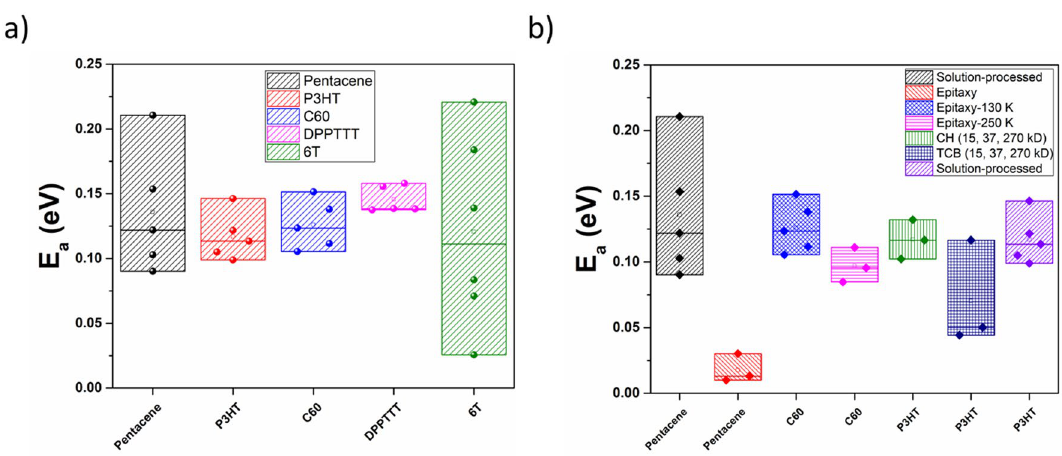
Figure 4. ( a , b ) Plots consisting of activation energy (E a ) derived from the Renormalization Model, accessed by different OFETs. The horizontal axes denote the semiconductor for which the activation energy E a is plotted on the vertical axes. For each organic system, the plots display the entire range of E a values, with the data points being indicated by solid symbols. The minimum and maximum E a values are marked by the topmost and bottommost data points, respectively. The corresponding mean and median E a values for each OFET are indicated by the unfilled square and horizontal line, respectively, within each box; ( a ) activation energies (E a ) accessed by each OFET as calculated from the range of gate voltages used in calculating the mobility- temperature dependence for each molecule. The E a values have been calculated from the values of T r and T p for each curve and are shown for each OFET (filled spheres). The inset shows the semiconducting material whose E a is plotted; ( b ) variation in the range of E a accessed by each OFET fabricated using different processing techniques for the same semiconducting material. The inset represents the different processing conditions used as indicated by varying box